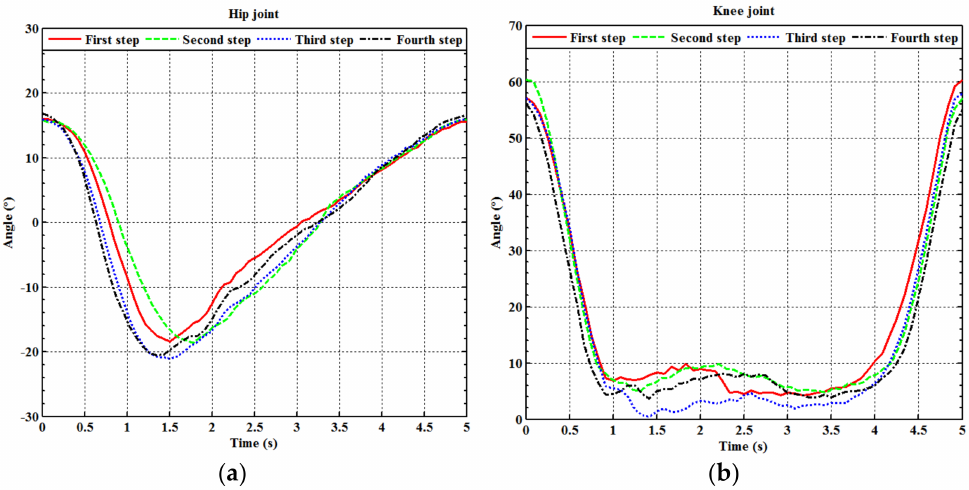
Figure 9. Fitting curves of full gait training cycle. ( a ) The hip of the right leg; ( b ) the knee of the right leg. Figure 10a,b, respectively, show the fitting curves for the hip and knee in five seconds,